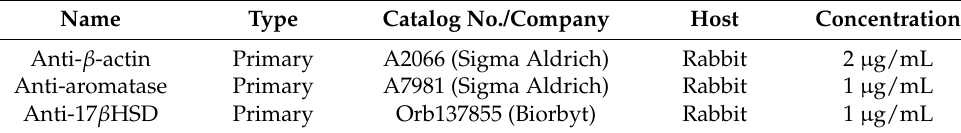
Table 5. The primary antibodies used for immunofluorescence and Western blotting